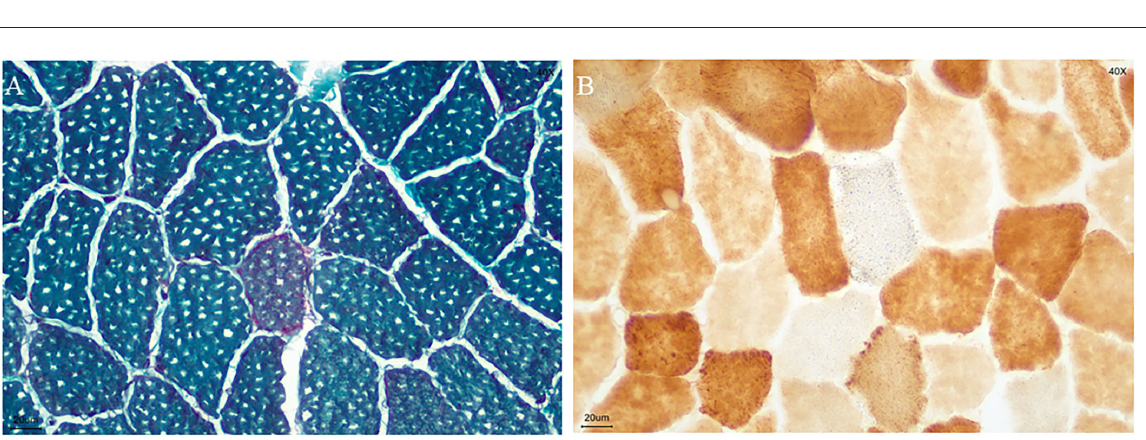
patient (Figures 3A,B). The mutations were heteroplasmic, with mutant mtDNA/total mtDNA ratios of 83 and 43%, respectively. The results of the WES were confirmed by Sanger